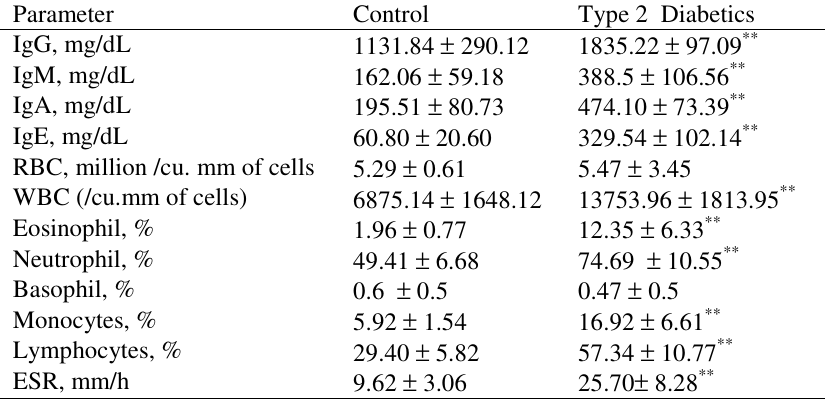
Table 2. Clinical characteristics of study subjects (Values are Mean ±